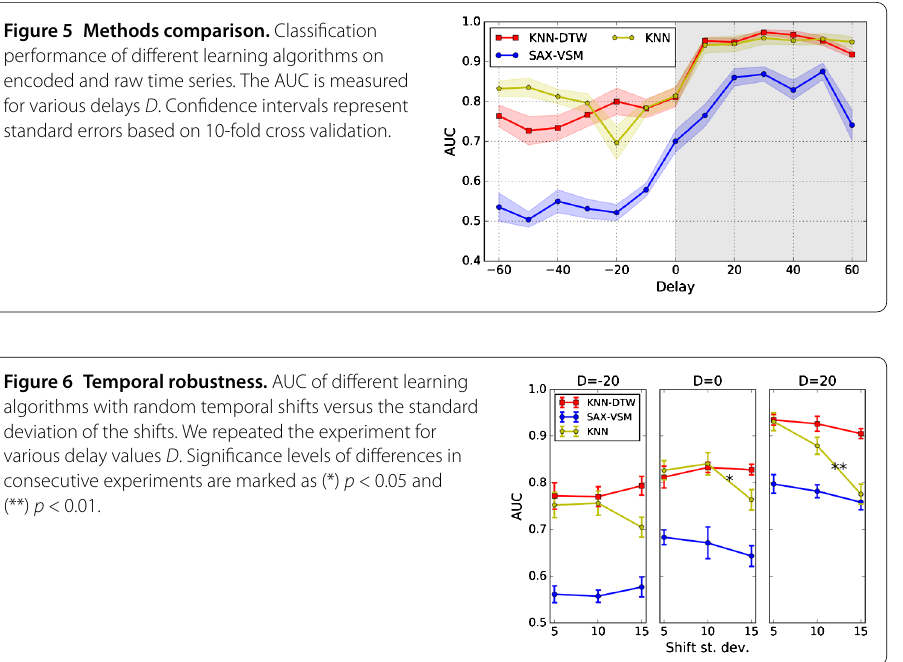
Figure 5 Methods comparison. Classification performance of different learning algorithms on encoded and raw time series. The AUC is measured for various delays D . Confidence intervals represent standard errors based on 10-fold cross validation.